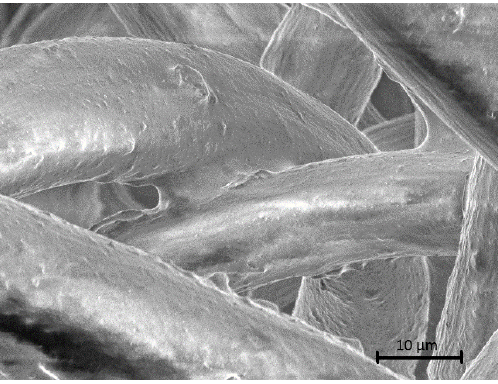
Figure 9. Morphology of PAN fibers after pressing at 180 °C [2].